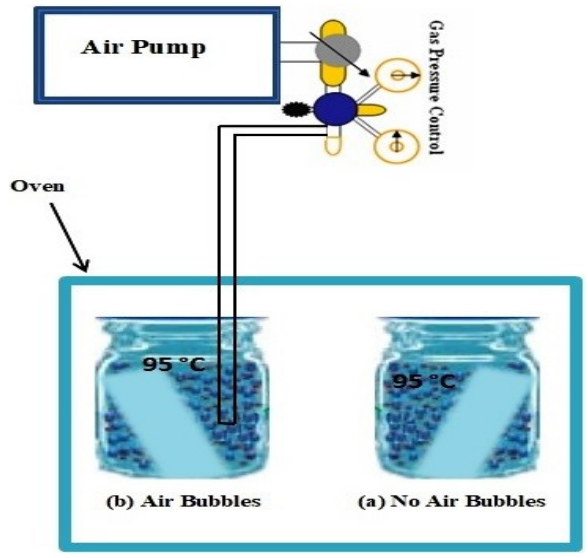
Figure 1. Schematic of Modified and Conventional CBD Method.